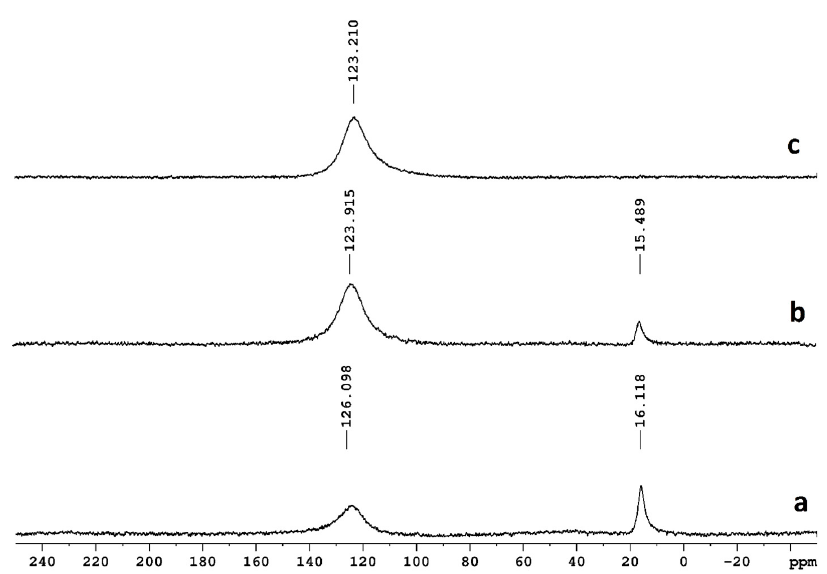
Figure 8. 95 Mo NMR data for Mo8 acidification: ( a ) 70 mg Mo8 + 2 mg of Hpts in 600 µ L DMSO- d 6 ; ( b ) 70 mg Mo8 + 5 mg of Hpts in 600 µ L DMSO- d 6 ; ( c ) 70 mg Mo8 + 10 mg of Hpts in 600 µ L DMSO- d 6 .